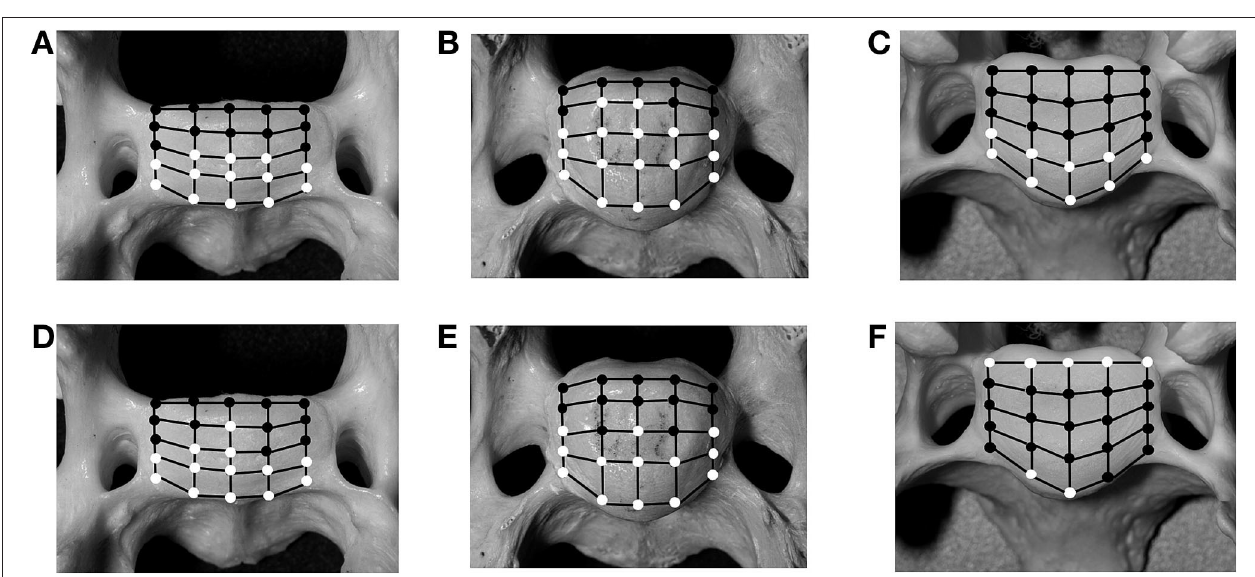
FIGURE 6 | Schematic illustration of 25 predefined landmarks on the cranial bony vertebral endplate of a vertebral specimen from a cat (A,D) and a dog (B,E) . In comparison, images from a medium-sized dog are shown (C,F) as previously published (20). Locations that have significant ( p < 0.05) changes for intervertebral disc (IVD) measurements in either of the motion extremes [flexion (A–C) and extension (D–F) ], compared with values for the neutral position, are indicated as white circles, whereas locations with non-significant changes are indicated as black circles. in extension ( + 11.4 ± 1.0 ◦ ; p = 0.003; Figure 5 ). The total ROM between flexion and extension was also higher in cats ( p =